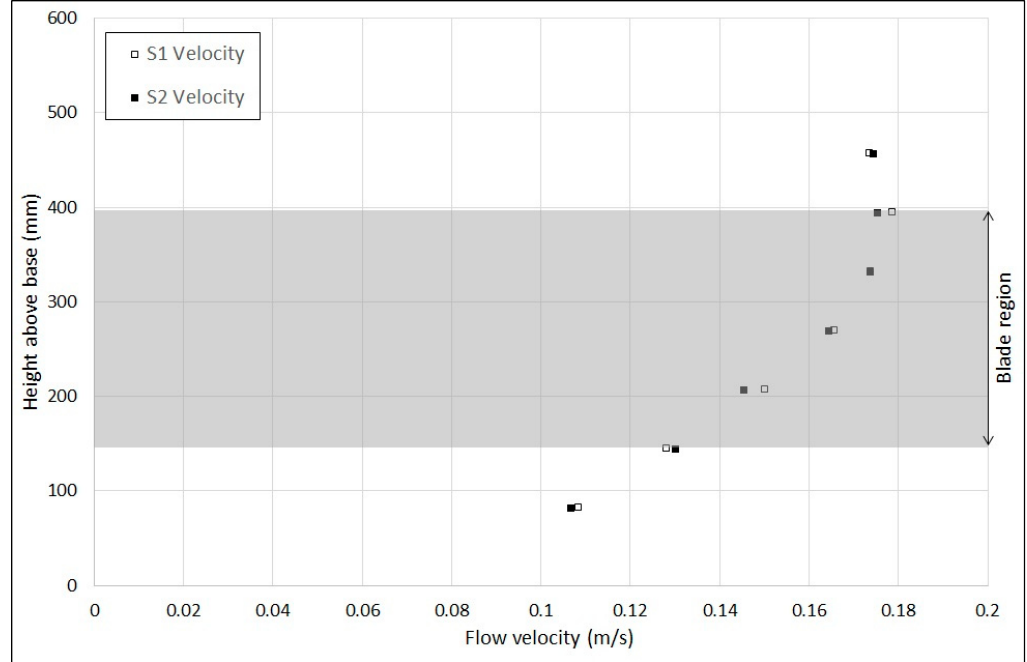
Figure 10. Mean flow velocity recorded at blade plane. S1 and S2 support structures, nacelle in place, blades removed (4096 samples at 25 Hz per point).